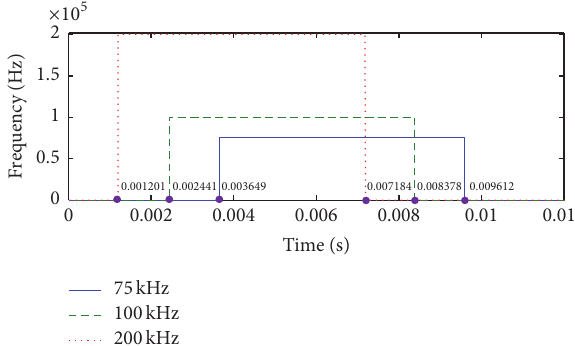
Figure 11: The final IFs of the sample signal by using the presented algorithm.